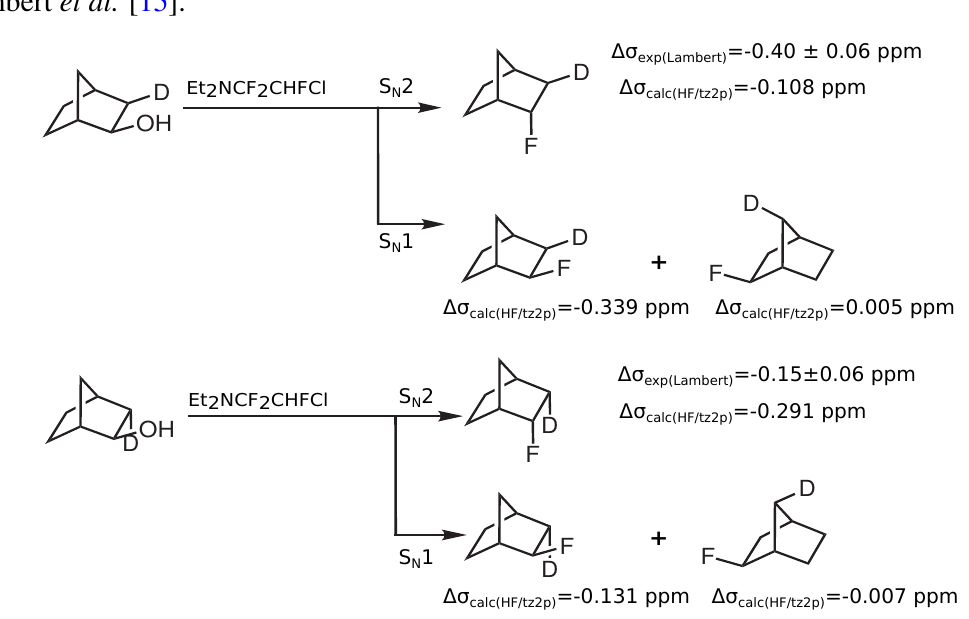
Figure 3. Computed 19 F secondary isotope shifts of proposed products occurring from S 1 and S 2 mechanisms in comparison to 19 F secondary isotope shifts obtained by N N Lambert et al.